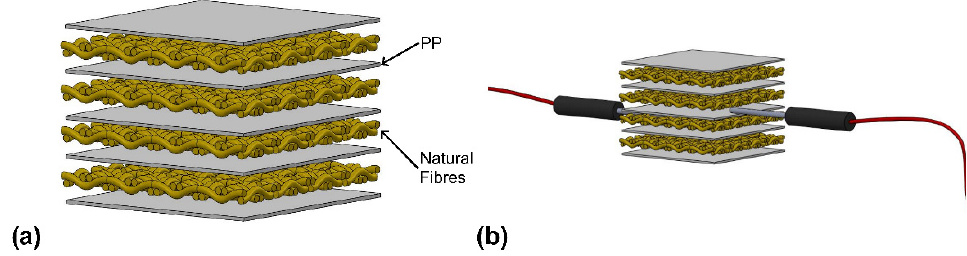
Figure 1. ( a ) Fabric adopted as reinforcement and ( b ) magnification of hemp and flax yarn.